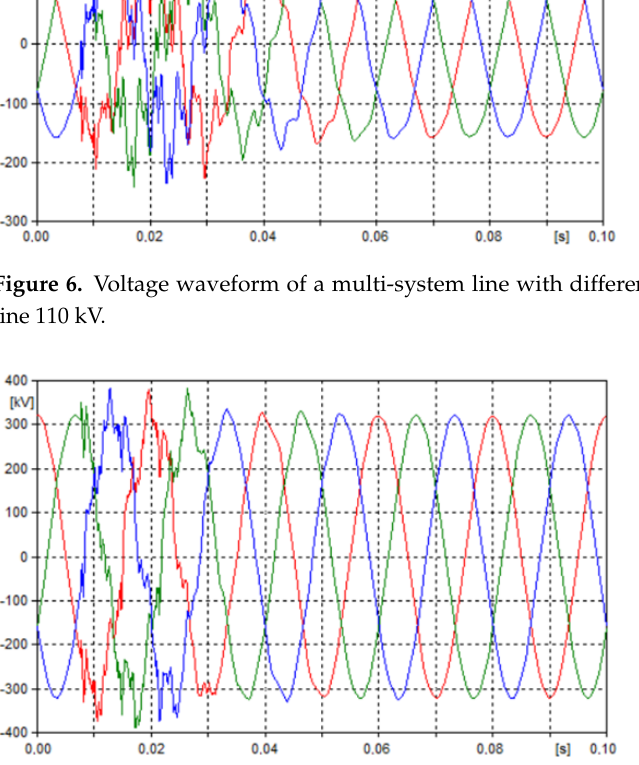
Figure 7. Voltage waveform of a multi-system line with different voltage levels for transmission line 220 kV.